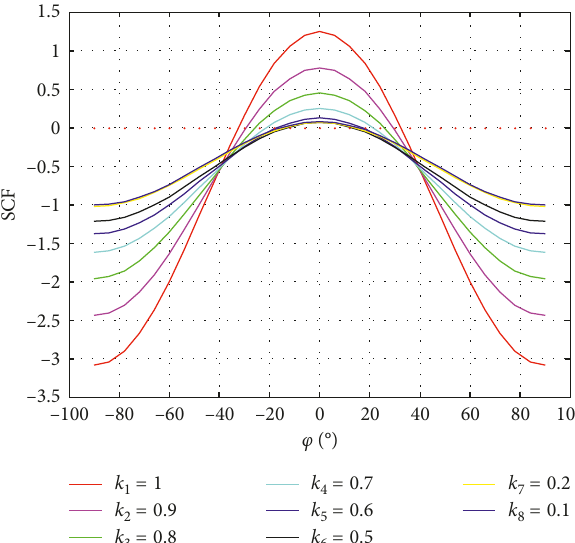
Figure 4: SCF curves for the rock near an empty hole ( m